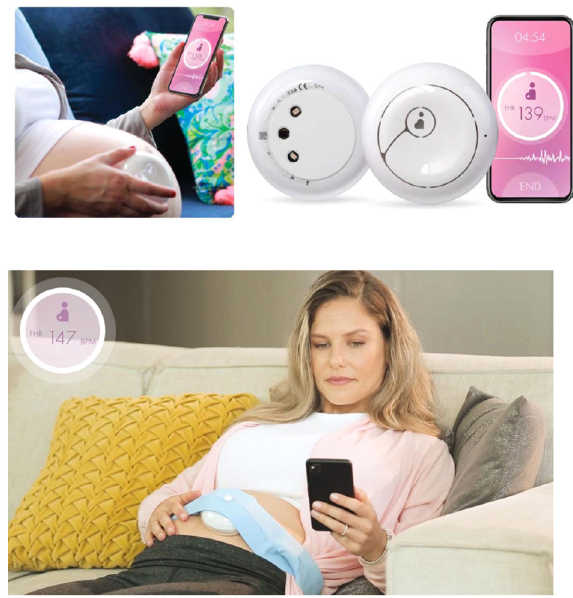
Fig. 5 Fetal heart rate monitoring system. Device and integrated smartphone interface. Hand held and with disposable stability belt Image (courtesy of HeraMED Ltd. Used with permission).